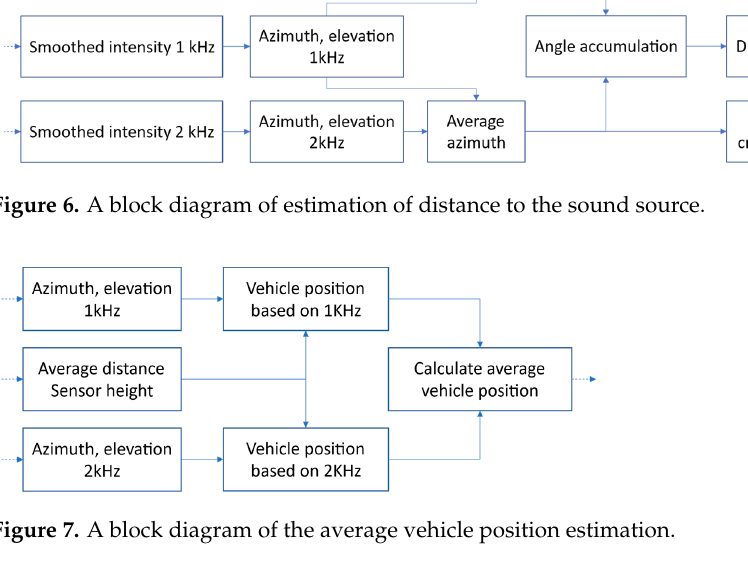
Figure 5. Block diagram of signal preprocessing and calculation of the smoothed intensity signals in frequency bands.